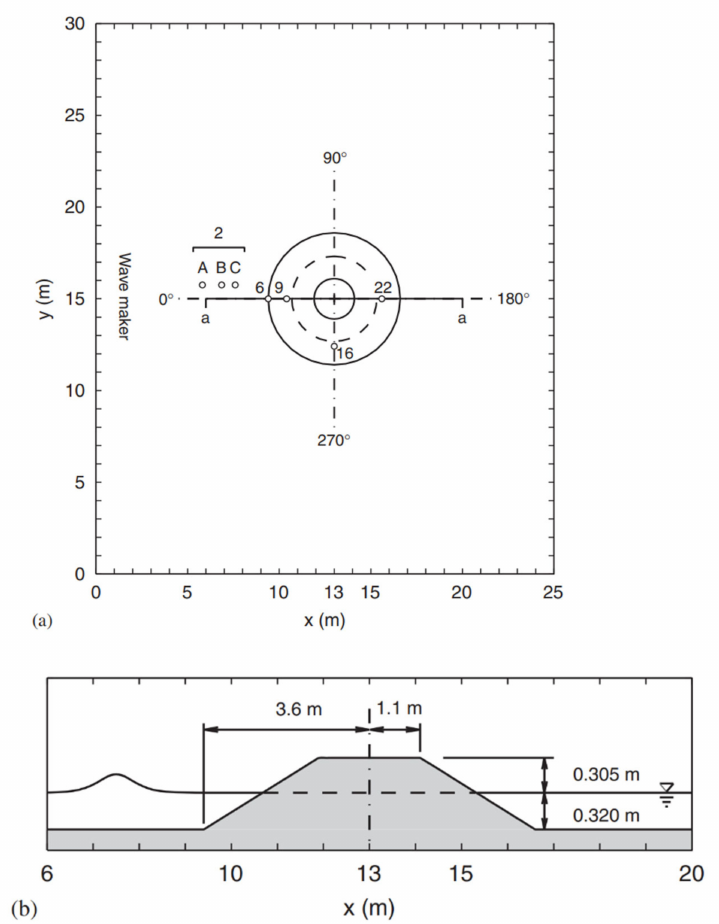
Figure 10. Schematic sketch of the conical island experiment. ( a ) Plane view, ( b ) side view, o gauge locations (from: Yamazaki et al. [33]).